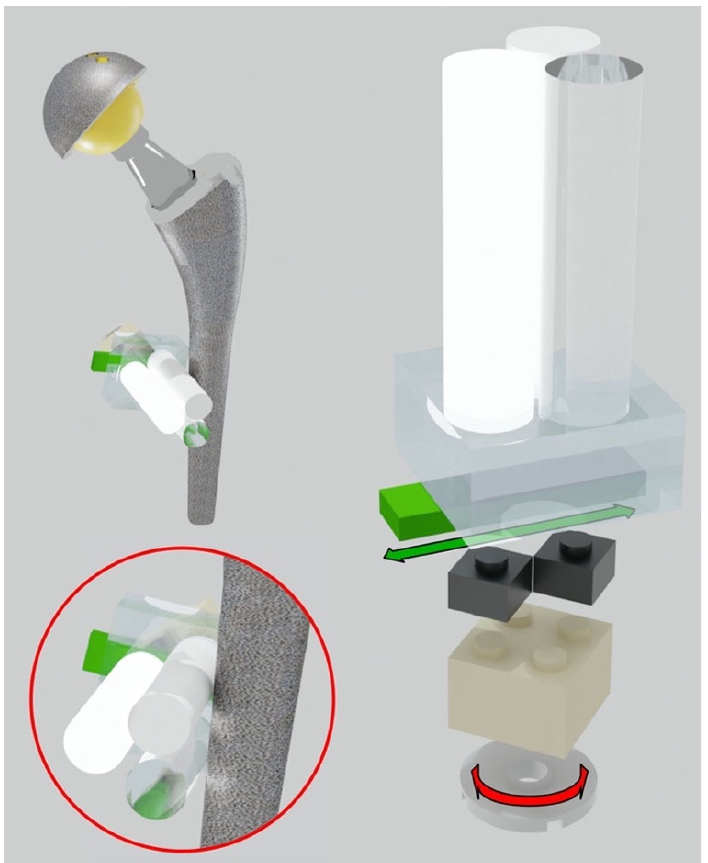
Figure 1. Adjustable system to put the triplets in direct contact with the hip prosthesis. Translational and rotational degrees of freedom of the triplets. Diagnostics 2023 , 13 , 50